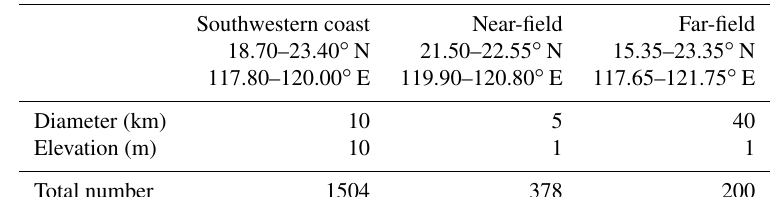
Table 1. Parameters of the unit sources adopted in the IIA method for the three domains.